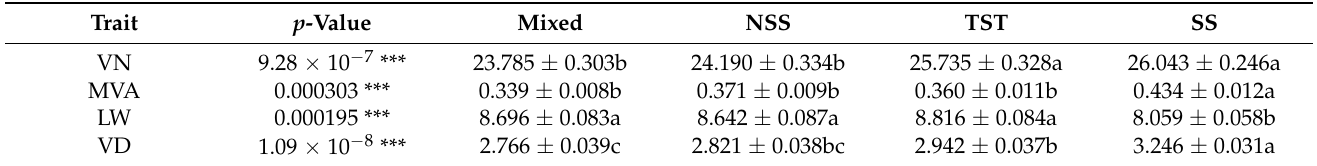
Figure 3. Correlation analysis of leaf veins’ phenotypic traits at ear leaf of maize among 300 inbred lines.